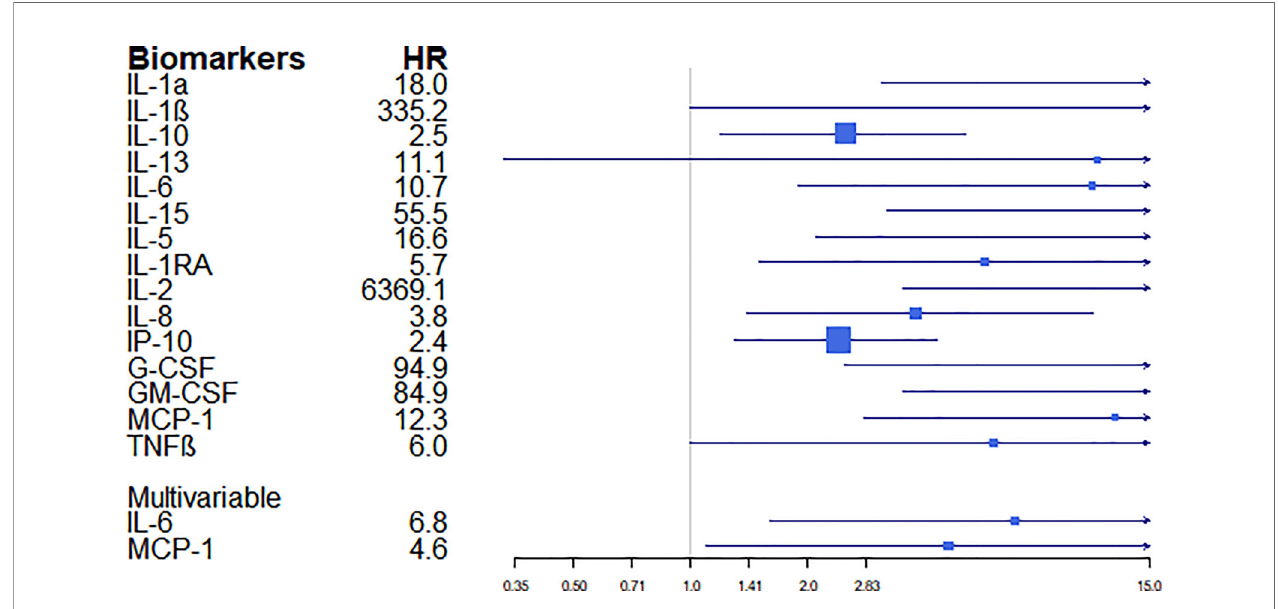
FIGURE 6 | Estimates of the magnitude of association (hazard ratios – HR-) and their con fi dence intervals between biomarkers and the outcome “ death ” . HR were computed by univariable and multivariable Cox